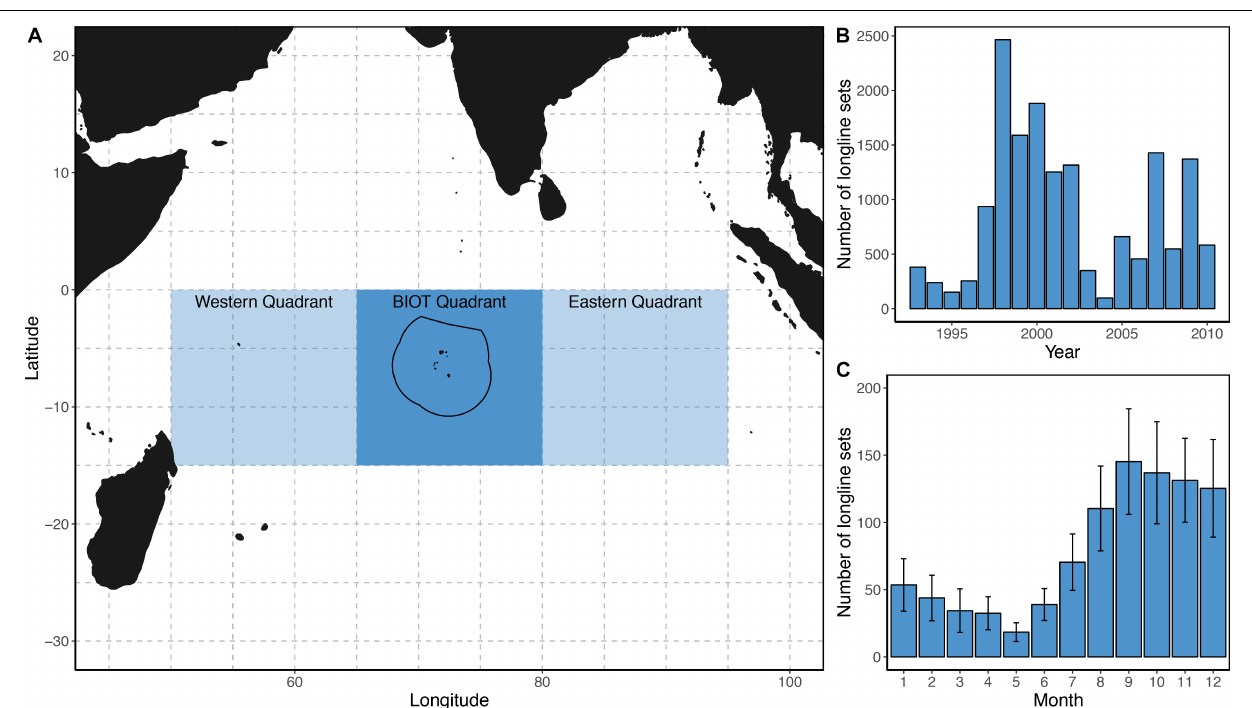
FIGURE 1 | The location of the British Indian Ocean Territory (BIOT) (A) . Dashed grid lines represent the Indian Ocean Tuna Commission longline reporting grid cells. The solid line denotes the BIOT marine protected area boundary with the shaded areas depicting the three quadrants (the BIOT Quadrant, the western Quadrant and the eastern Quadrant) used in subsequent analyses. The total number of longline fishing sets recorded per year within the BIOT between 1993 and 2010 (B) , and the mean number of longline fishing sets recorded per month in BIOT across all years (C) . Error bars represent ± standard error.